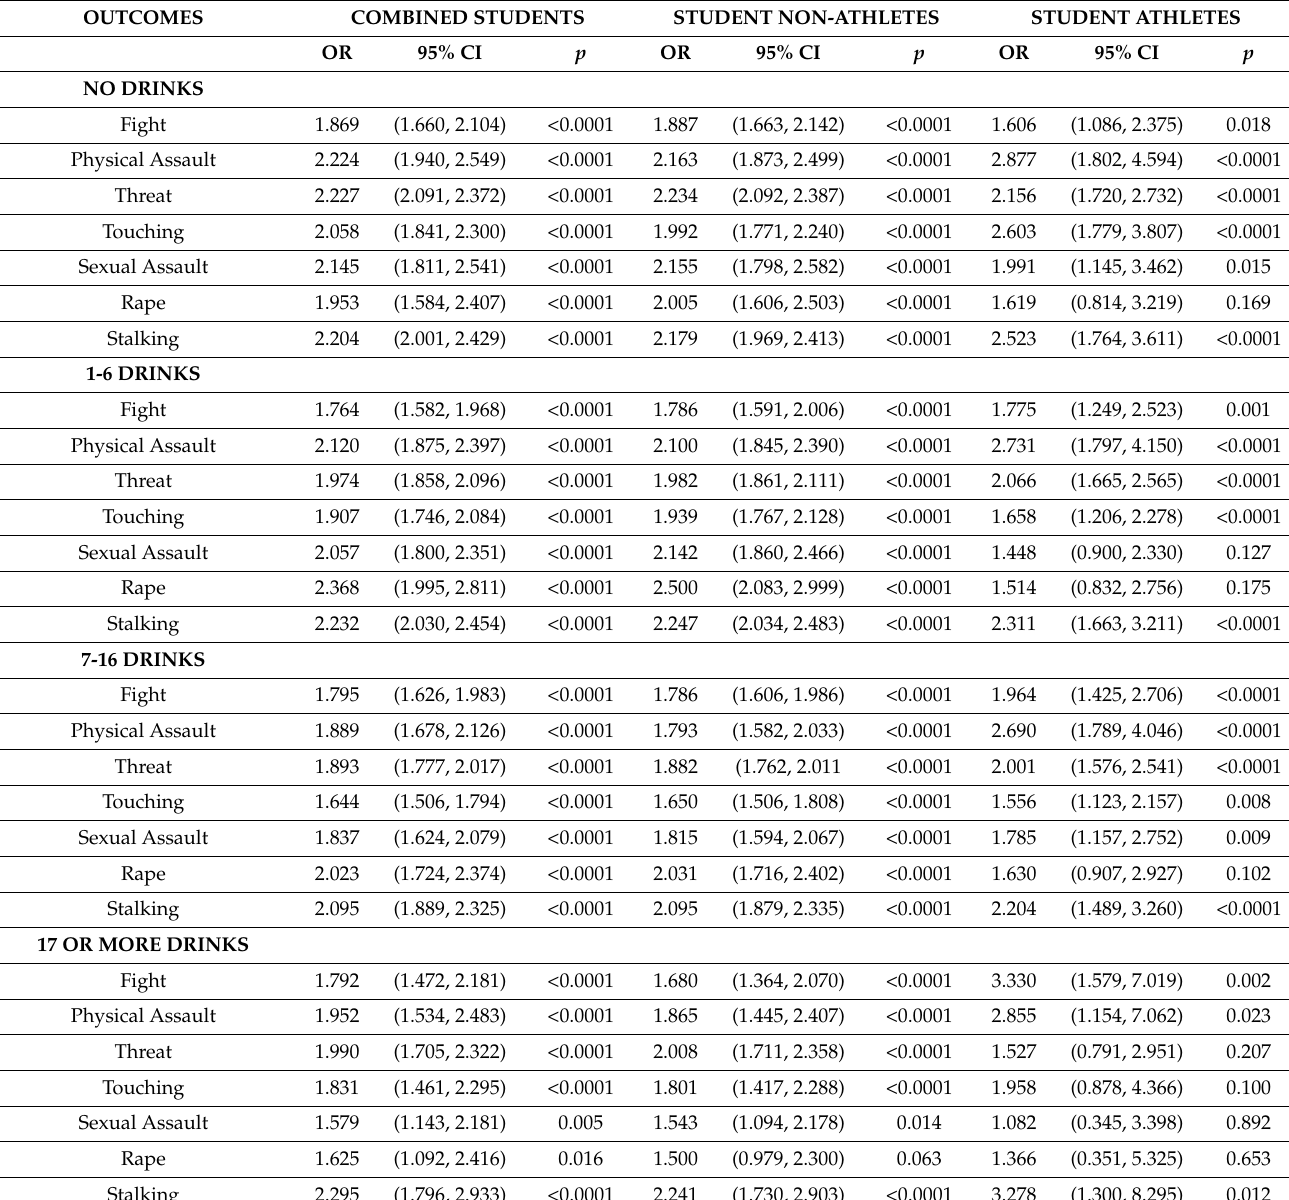
Table 4. Association between increasing alcohol use and sleep difficulties: three categories of student status: combined, student non-athlete and student athlete (controlling for depressed